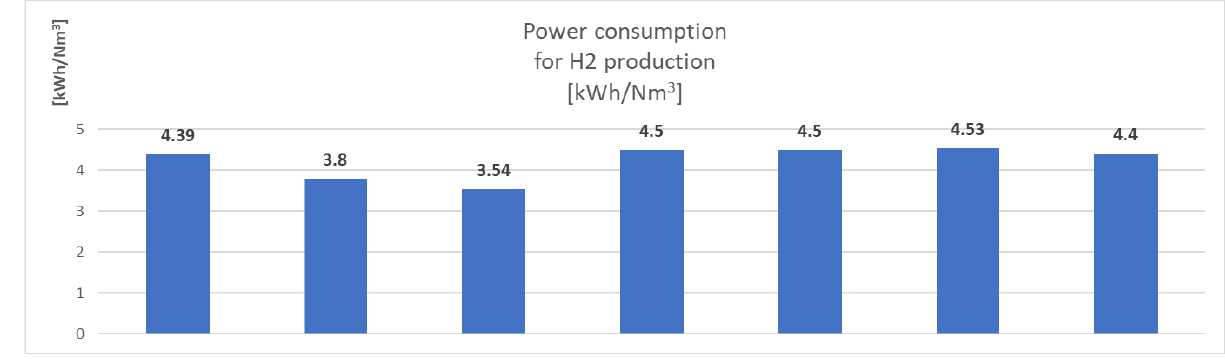
Figure 11. Power consumption for producing 1 Nm 3 of H 2 [86,92,93,102,118,120]. The H 2 production indicator varies from 3.09 [Nm 3 /h] with an electrolysis system size